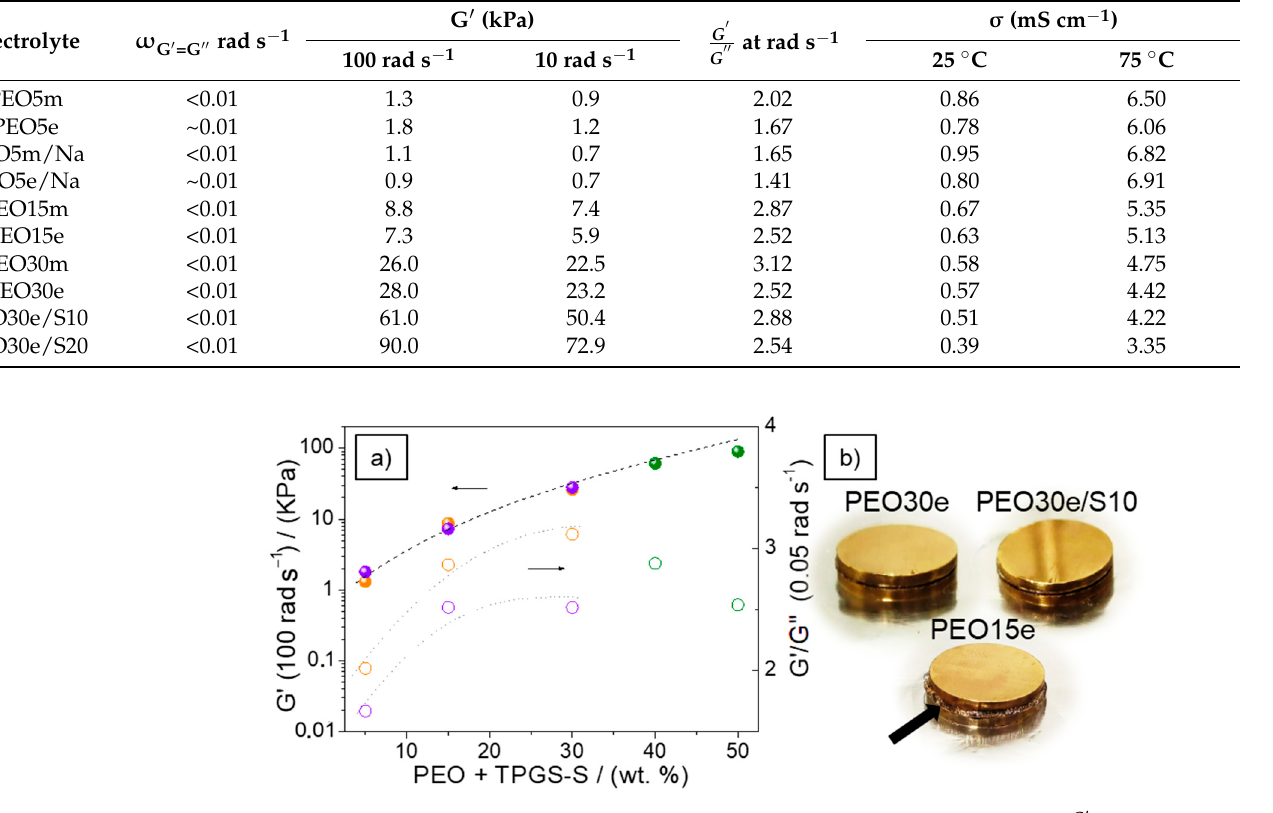
Figure 3. ( a ) Elastic moduli variation with (PEO + TPGS − S) wt.% (solid circles) and G (cid:48) s − 1 (open circles). Orange for manual mixed samples, violet for extruded samples and green for the electrolytes with TPGS-S. ( b ) Pictures showing the dimensional stability of the electrolyte PEO30e after enduring a load of 0.5 kg at 70 °C for 20 min.